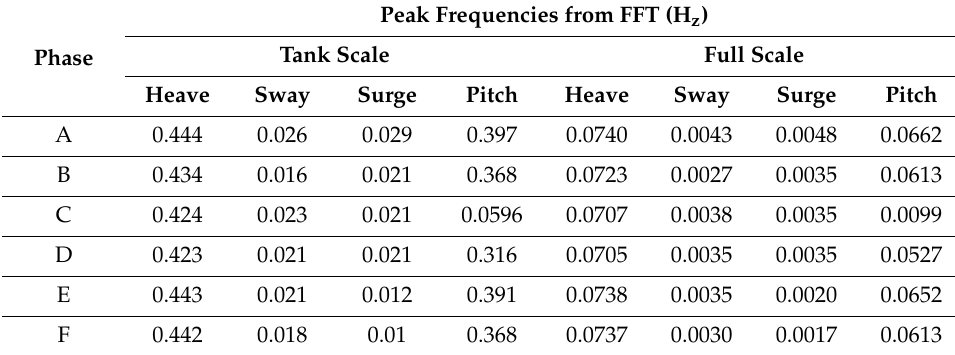
Figure 7. Fast Fourier transform (FFT_ of free decay of heave motion for all phases of testing.